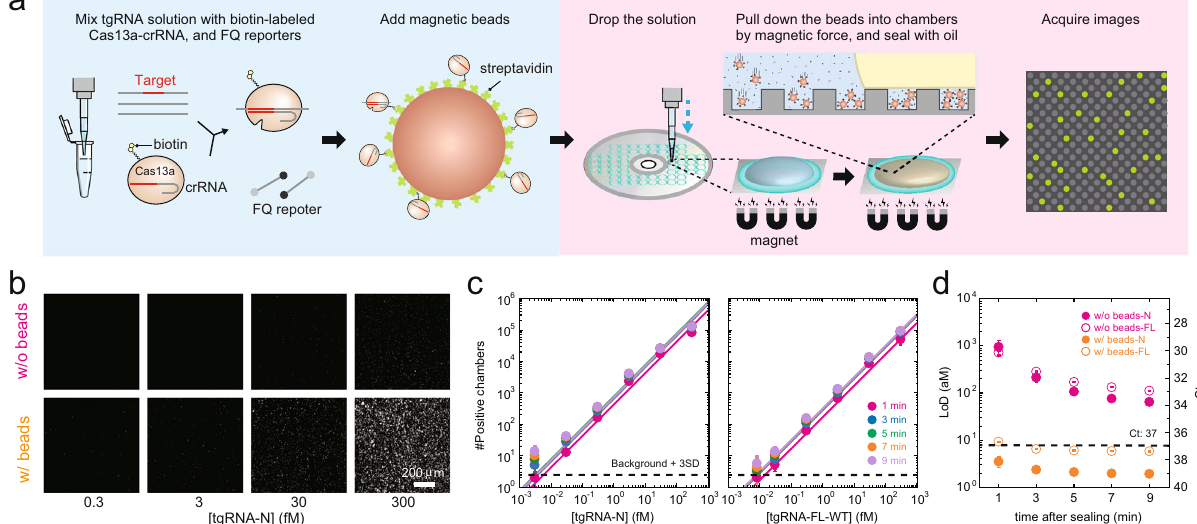
Fig. 2 opn-SATORI. a Schematic illustration of opn-SATORI. Biotin-labeled LtrCas13a-crRNA-tgRNA complexes were attached to streptavidin-coated magnetic beads and enriched in microchambers by a magnetic force before the sealing with oil. b Representative images obtained with or without magnetic bead treatment at different concentrations of the SARS-CoV-2 N-gene. c The number of positive chambers obtained using different concentrations of SARS-CoV-2 N-gene or whole genome RNA. The solid lines indicate linear regressions. The values of the background mean + 3 S.D. are indicated by dotted lines. d Time courses of LoD values with or without the magnetic bead treatment, for detection of the SARS-CoV-2 N-gene or whole genome RNA. The dotted line indicates the Ct value of 37 for the SARS-CoV-2 whole genome RNA evaluated by RT-qPCR. ( n = 3 technical replicates for c and d